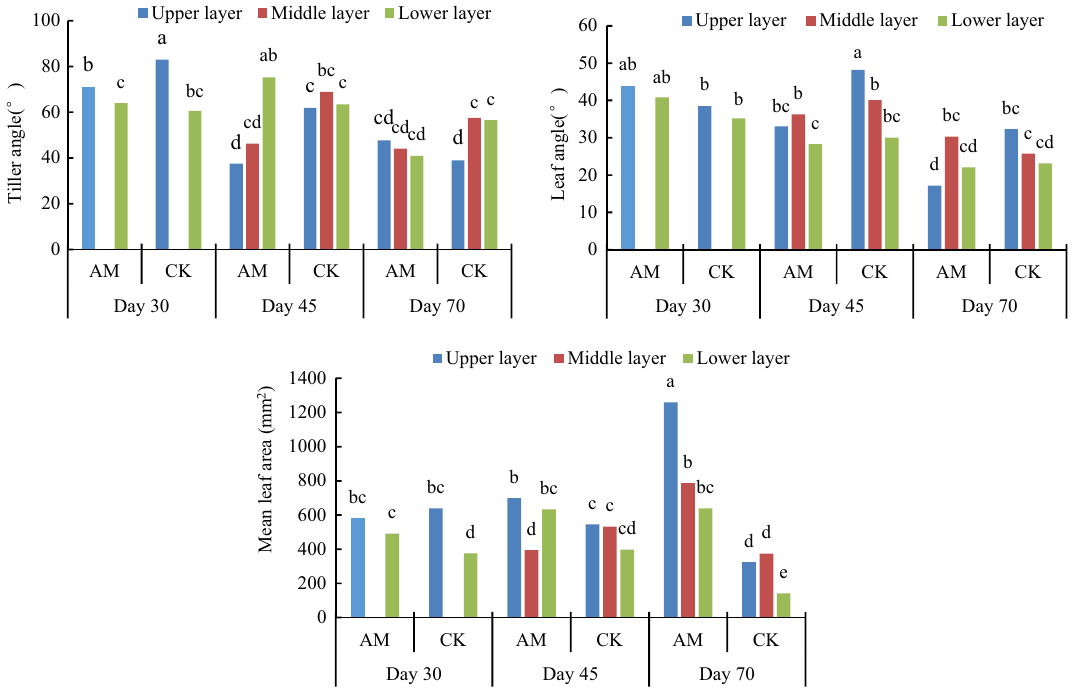
Figure 2. Effects of AMF inoculation on complex characteristics of the peanut canopy; within each parameter, bars without the same letter are significantly different by LSD ( p < 0.05).